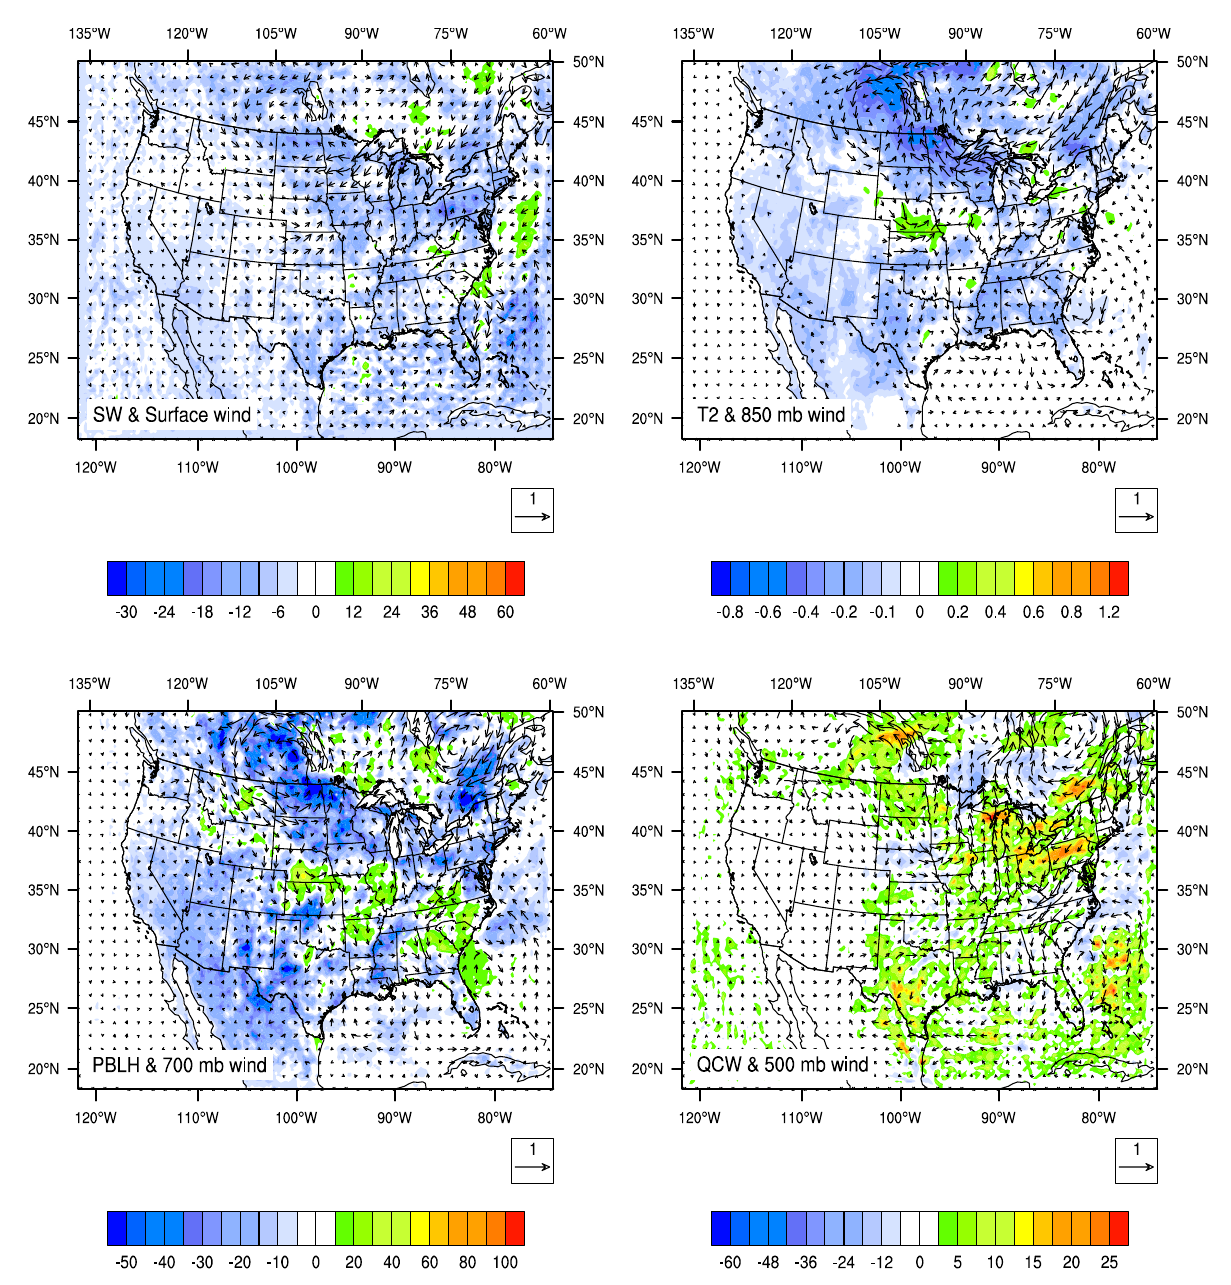
Figure 5. Same as Figure 4 except for changes due to